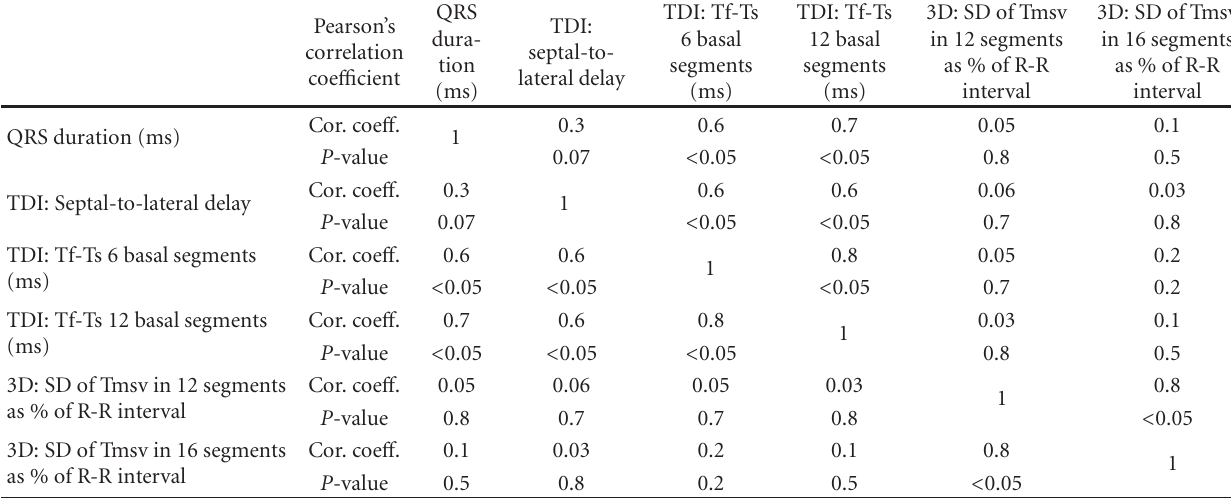
Table 5: Correlation between left ventricular dyssynchrony indices by QRS duration, TDI, and 3D volumetric analysisin patients undergoing